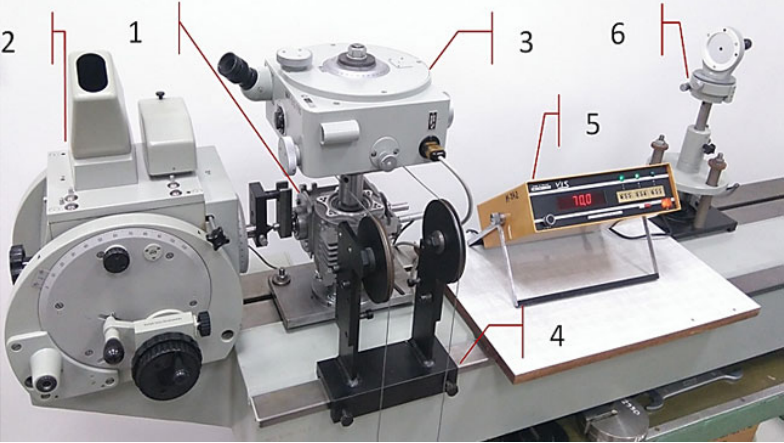
Figure 16. Testing stand—general view: 1—worm, 2—optical measuring head P 3, 3—autocollimator, 4—worm wheel loading mechanism, 5—induction sensor with displacement gauge, 6— autocollimation